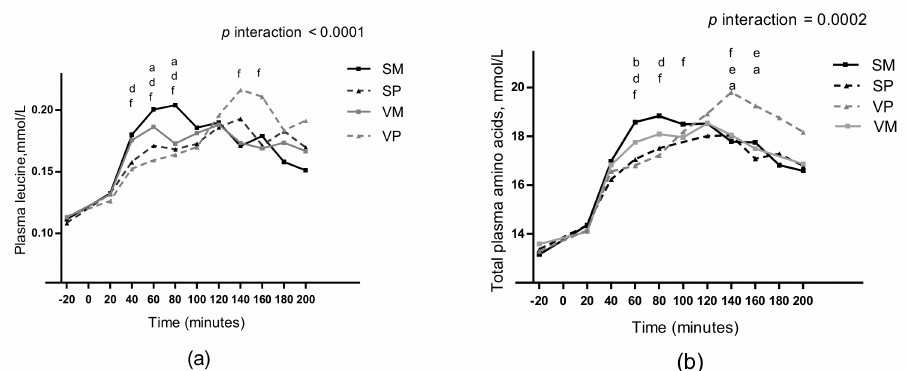
Figure 5. Mean unadjusted changes in plasma leucine ( a ) and total plasma amino acids ( b ), after intake of four different test meals: SM, SP, VM, and VP. Data are presented as means ± SEM, n = 5. Data were analyzed as repeated measures including a meal-time interaction using linear mixed models. Post hoc comparisons were single-step adjusted. a difference between the VM and VP meals ( p < 0.05), b difference between the VM and SM meals ( p < 0.05), d difference between the SM and SP meals ( p < 0.05), e difference between the SP and VP meals ( p < 0.05), f difference between the SM and VP meals ( p < 0.05). SM, salmon and mashed potatoes; SP, salmon and pasta; VM, veal and mashed potatoes; VP, veal and pasta.